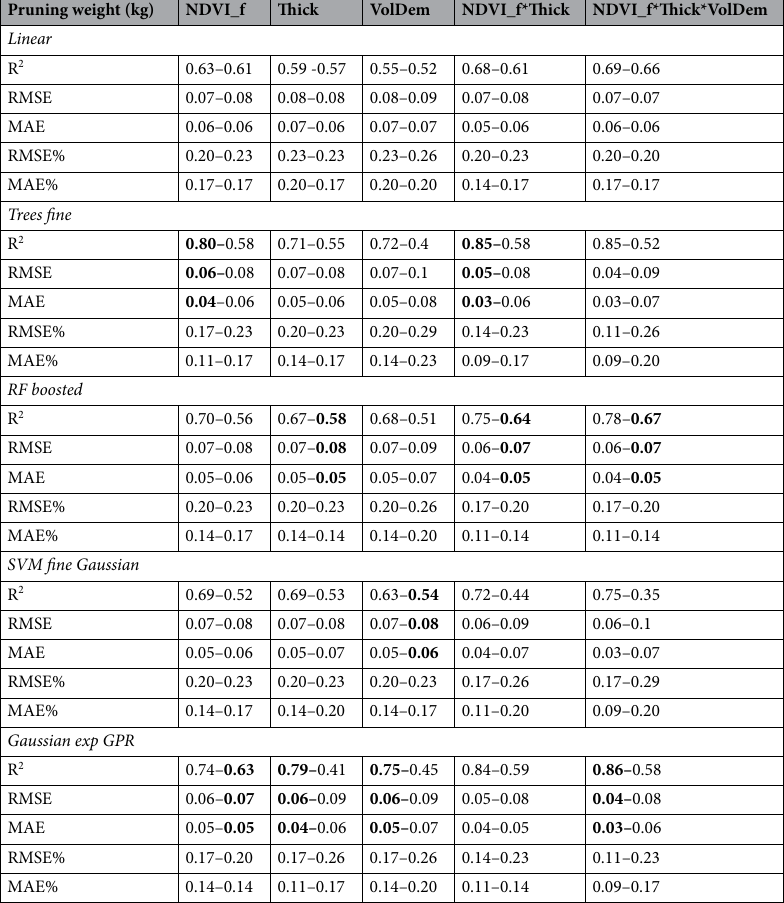
Table 5. Regression model’s performance (R 2 , RMSE, MAE, RMSE%, MAE%) obtained from the complete dataset (2017–2018–2019) between pruning weight and NDVI filtered (NDVI_f), canopy thickness (Thick), canopy volume (VolDem), NDVI filtered and canopy thickness (NDVI_f Thick), NDVI filtered, canopy thickness and canopy volume (NDVI_f Thick VolDem). Each cell presents 2 values, the first calculated without cross validation, and the second using fivefold cross validation. The best resulting models are bold